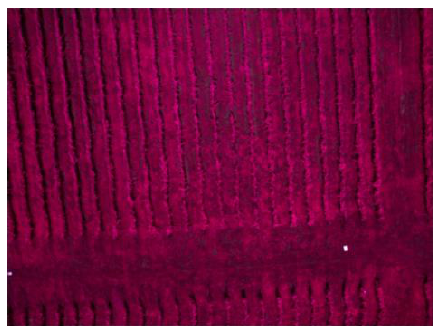
Figure 9. Multi-spectral orthophoto Post-processing of the images allowed the NDVI index to be estimated for both measurement sessions in July and September.